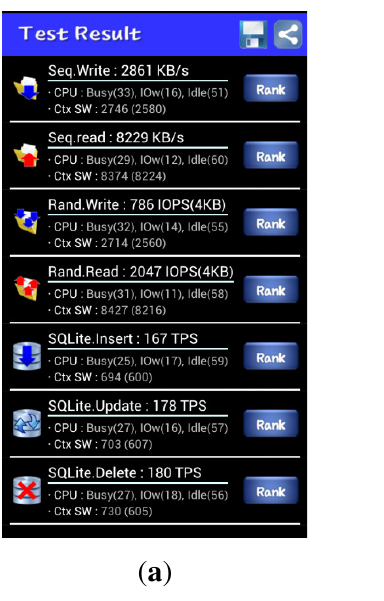
Figure 3. Function of data collection. ( a ) Result screen; ( b )